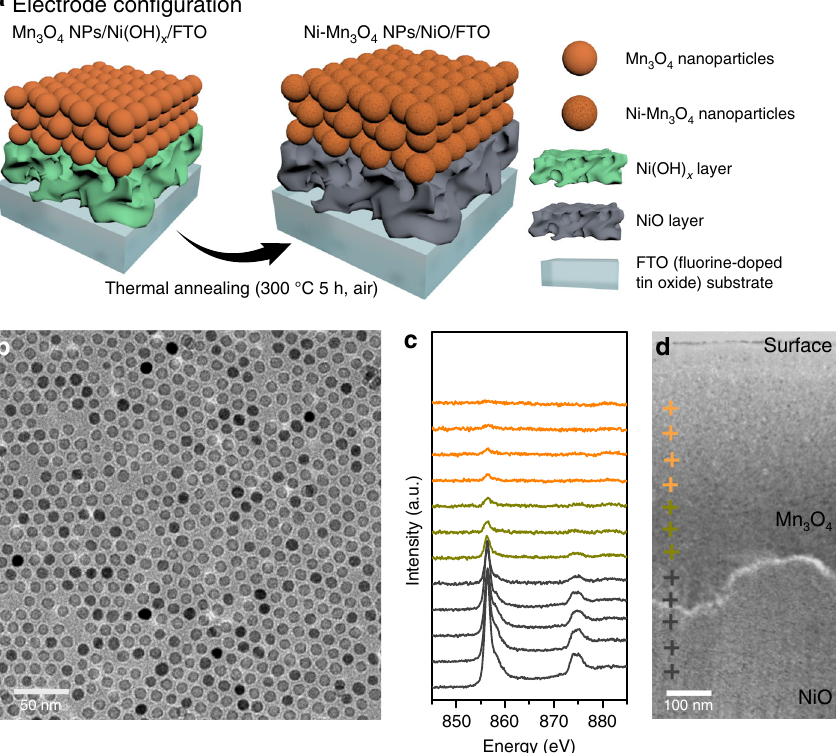
Fig. 1 Electrode material characterization. a Schematic illustration of the electrode con fi guration of the nickel-decorated Mn 3 O 4 NPs (Ni – Mn 3 O 4 NPs). b TEM image of the monodispersed 10-nm Mn 3 O 4 NPs. c HR-TEM EELS Ni L-edge spectra from the bottom (black) to the surface (orange) of Ni – Mn 3 O 4 NPs/NiO. The spot size for the EELS spectra is 10 nm. d Cross-sectional HR-TEM image of Ni – Mn 3 O 4 NPs/NiO. Each cross symbol corresponds to the EELS spectra in c